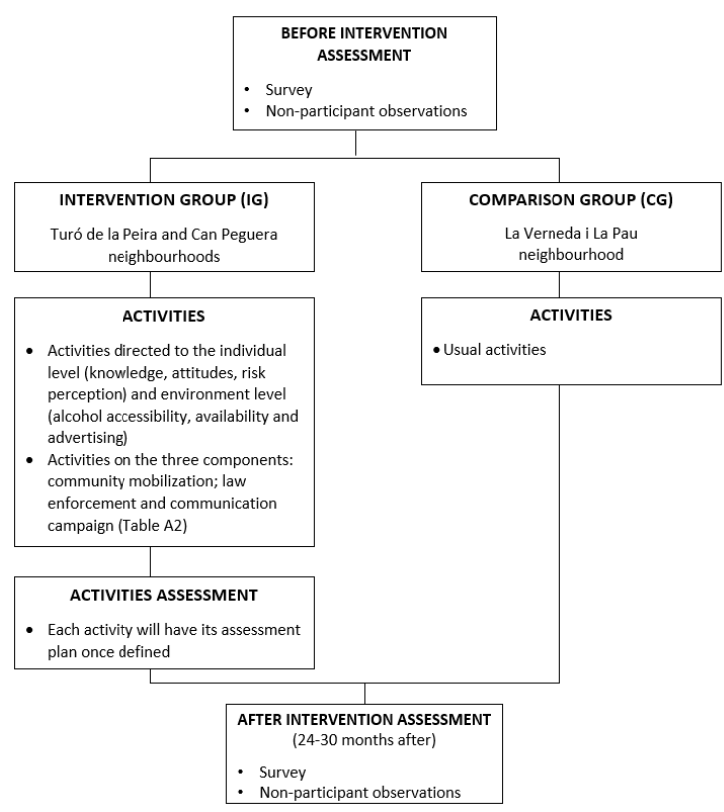
Figure 1. Flow chart of the study design.